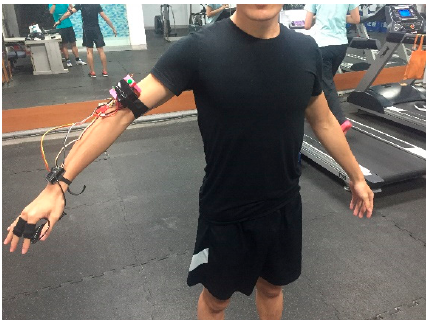
Figure 1. Architecture of the system.